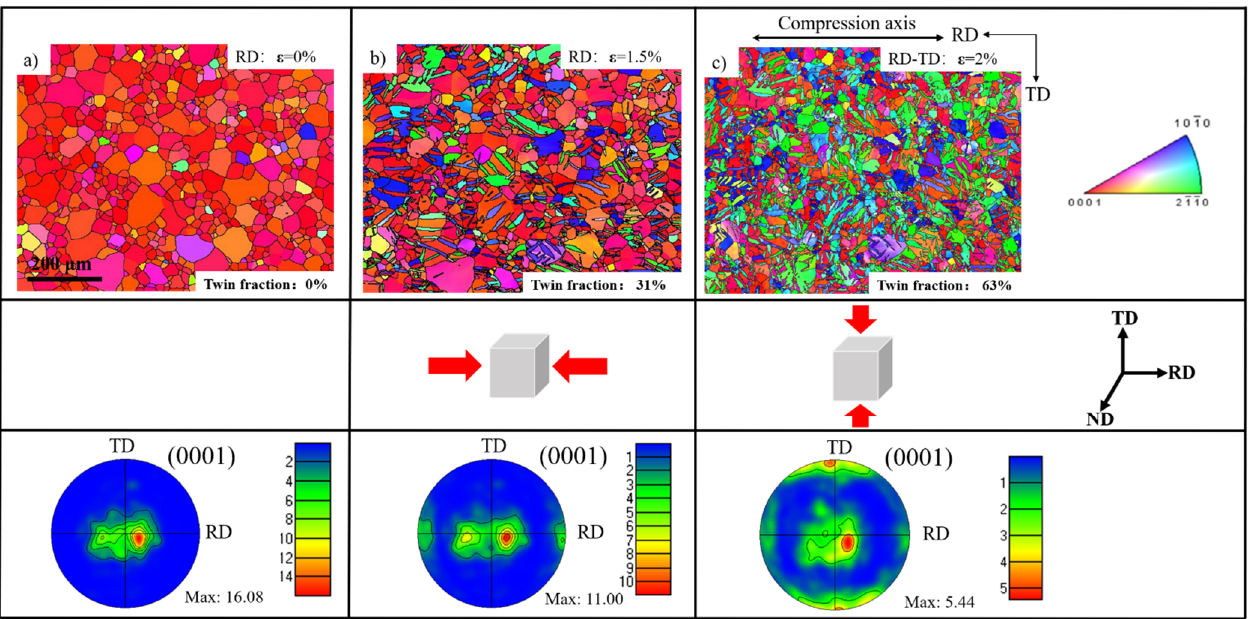
Figure 2. Microstructures and corresponding pole figures at strains of 0% ( a ), 1.5% ( b ), and 2% ( c ).